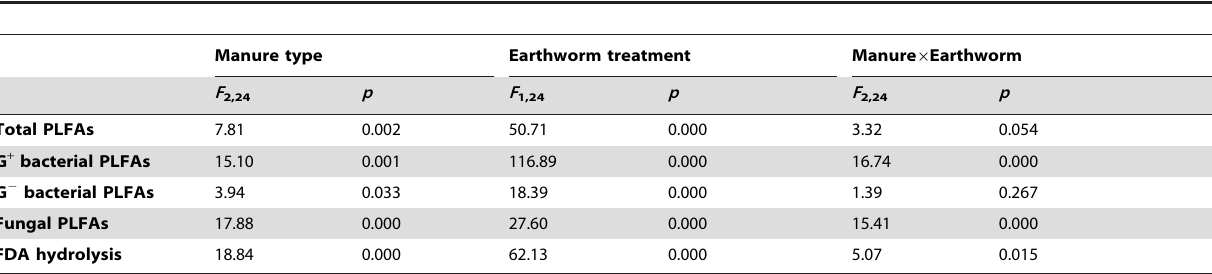
Table 2. ANOVA for total, Gram-positive, Gram-negative and fungal PLFAs and fluorescein diacetate (FDA) hydrolysis for the three types of animal manure (cow, horse and pig) incubated with and without